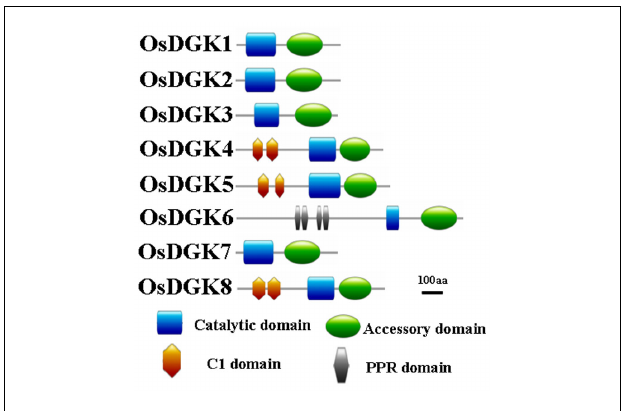
FIGURE 2 | Schematic presentation of the structure of OsDGK proteins. Conserved domains were identified by SMART and are highlighted in different